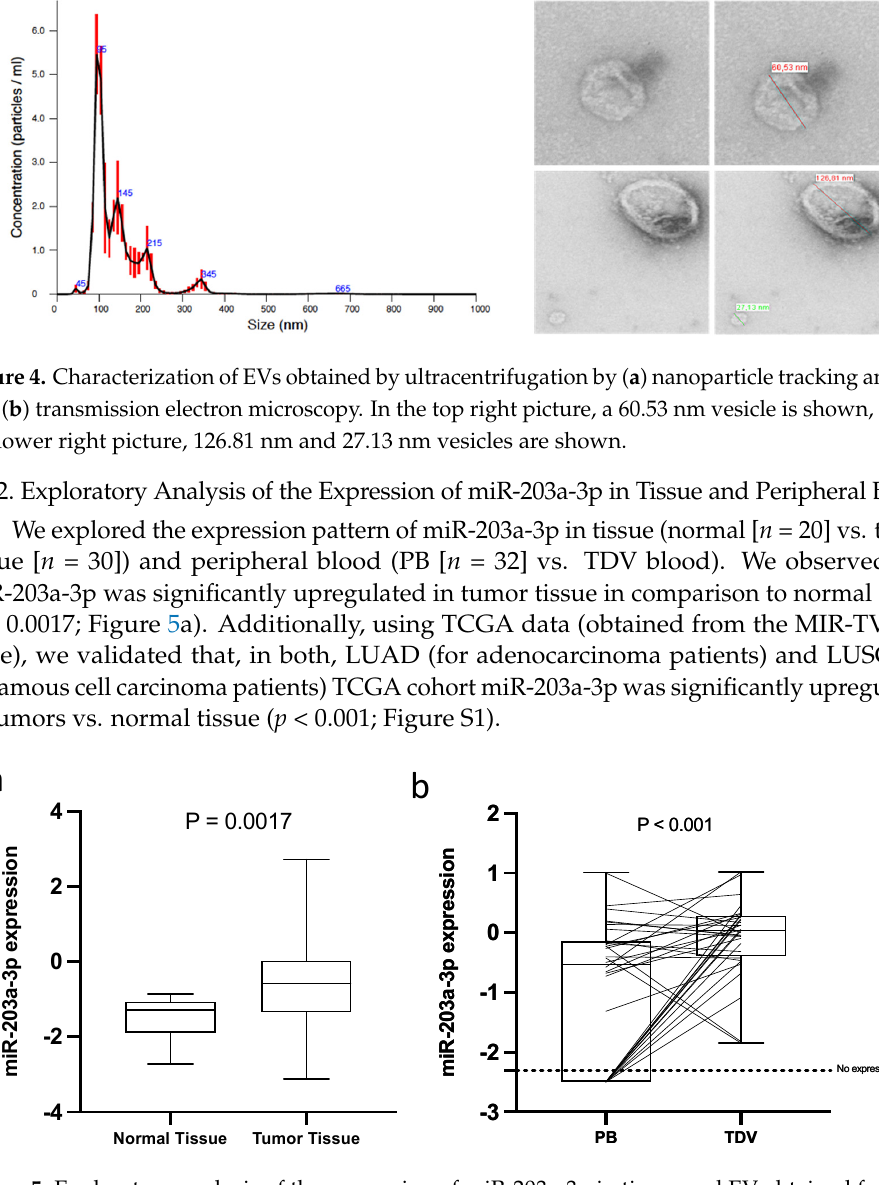
Figure 5. Exploratory analysis of the expression of miR-203a-3p in tissue and EV obtained from PB: ( a ) Boxplot showing the expression of miR-203a-3p in 20 normal tissues and in 30 tumor tissues. ( b ) Boxplot combined with before and after plot showing the expression of miR-203a-3p in 32 paired samples of EV from PB or TDV.